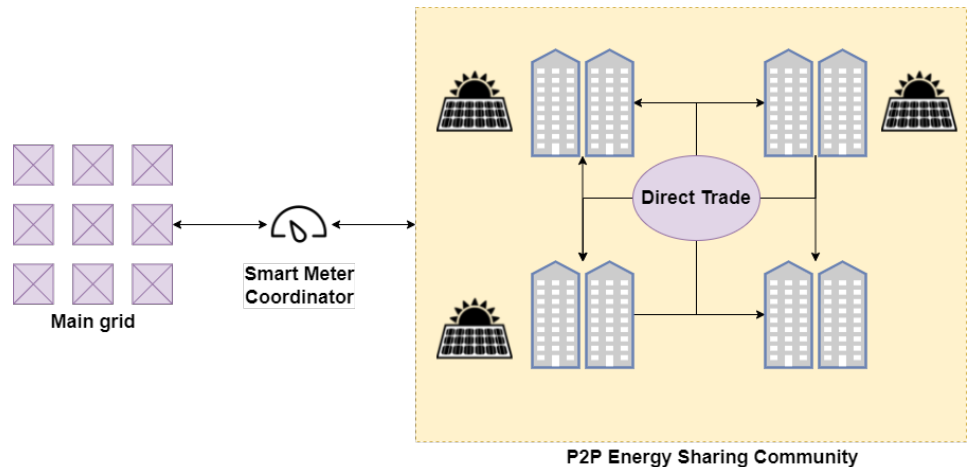
Figure 2. Basic diagram of a micro-grid architecture. The actors of the P2P network exchange energy locally and can potentially sell energy outside the community thanks to the existence of a smart meter